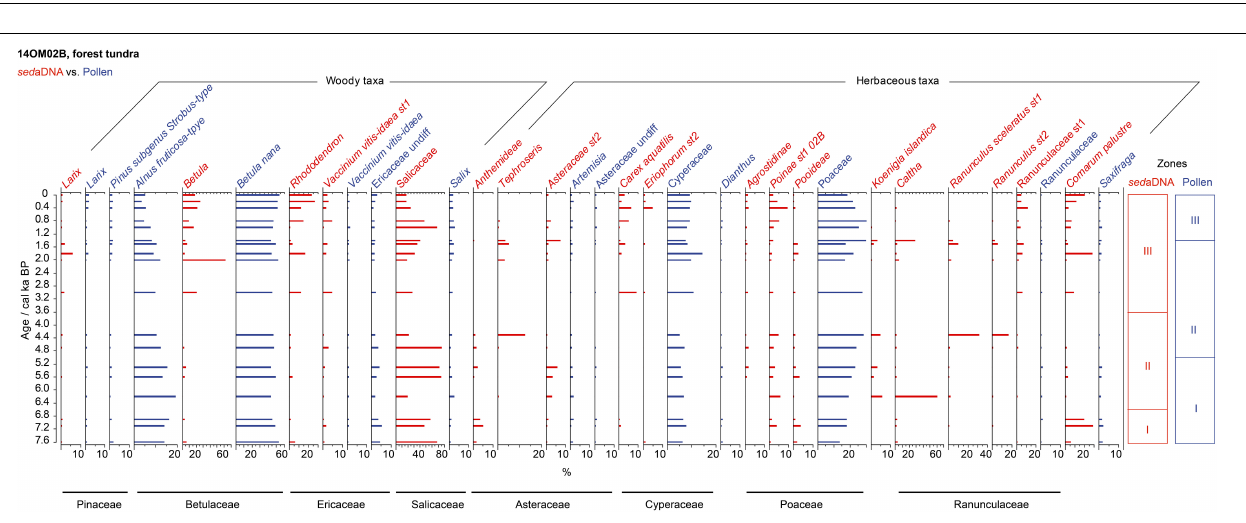
FIGURE 4 | Temporal changes in species diversity based on abundance data of seda DNA (A) and pollen (B) . The Hill numbers indicate species richness (q0), the exponential of Shannon’s entropy (q1) and the inverse of Simpson’s concentration (q2). The observed diversity, asymptotic estimates, and 95% confidence intervals are marked by solid lines, dashed lines, and shaded areas, respectively. Observed and asymptotic estimates overlie each other for q1 and q2.